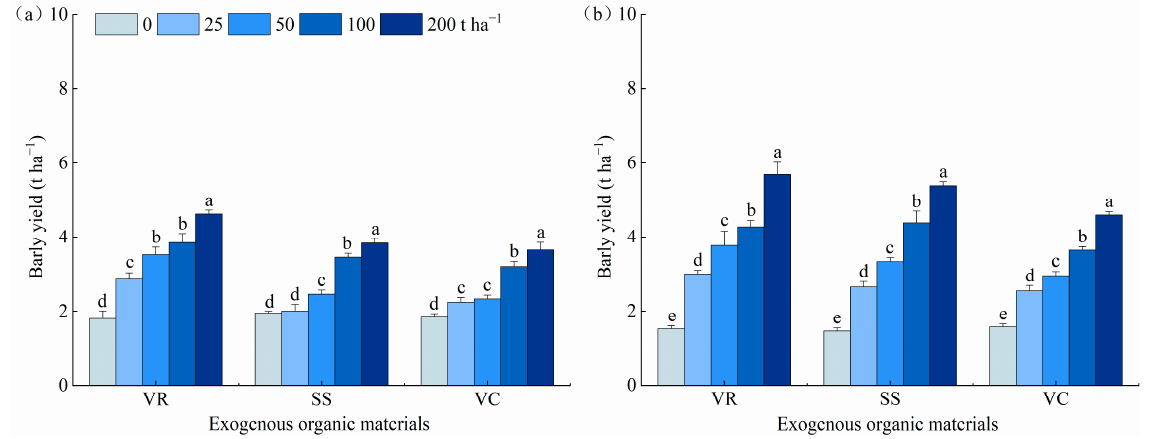
Figure 1. Barley yield in response to the application of different exogenous organic materials in saline-alkali soil: ( a , b ), barley yield in 2020 and 2021, respectively; VR, vinegar residue; SS, sewage sludge; VC, vermicompost; OM, organic material. The vertical bars denote standard errors. Different small letters denote significant difference at p < 0.05.